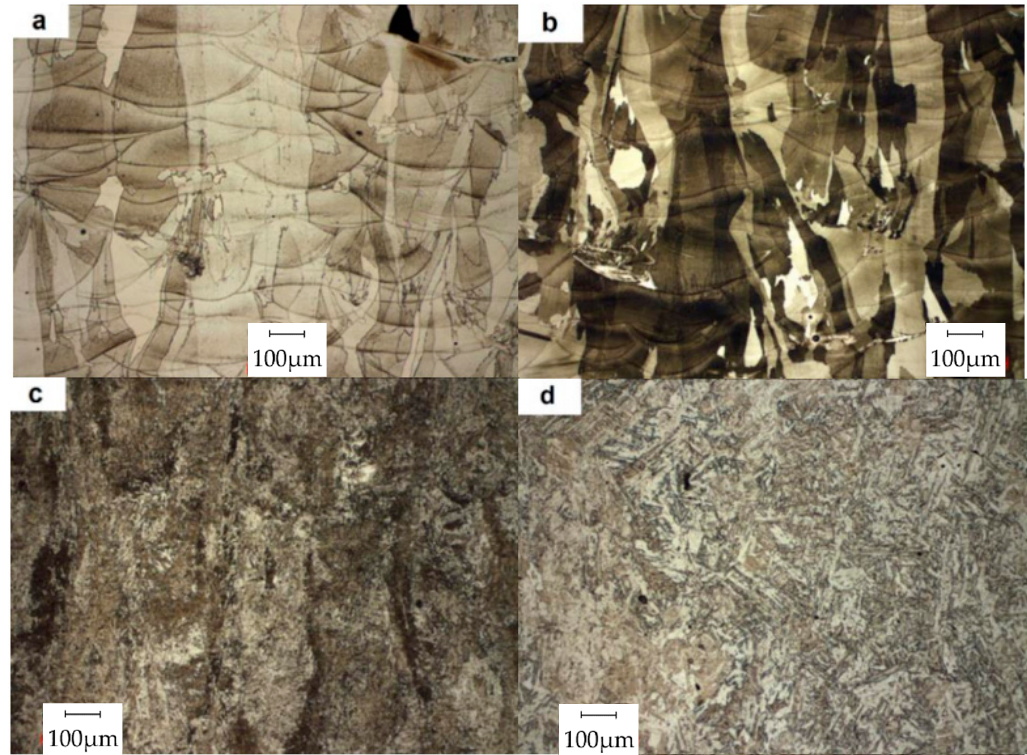
Figure 15. OM cross-section observation of L-PBF 17-4 PH sample (seen in Figure 14a) after heat treatment: ( a ) tempered at 480 °C/1 h; ( b ) tempered at 550 °C/4 h; ( c ) solution heat-treated (1040 °C/1.5 h), quenched and tempered at 480 °C/1 h; ( d ) homogenized (1190 °C/2 h), solution heat-treated (1040 °C/1.5 h) and tempered at 480 °C/1 h [136].